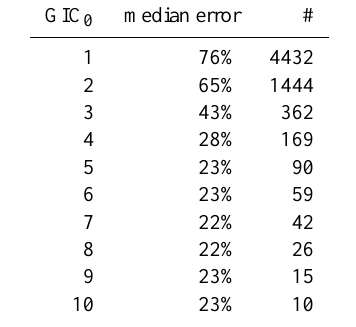
Table 7. Misfit of modelled GIC values at Rauma during the events listed in Table 3. The first column gives the lower limit of (abso- lute) GIC values considered. The second column gives the median error of modelled values. The last column shows the number of measured one-minute values larger than GIC 0 . Interpolated values of the magnetic field at Rauma were used to calculate the electric field. The conductivity of the uniform Earth was 0.01309 ohmm − 1 .